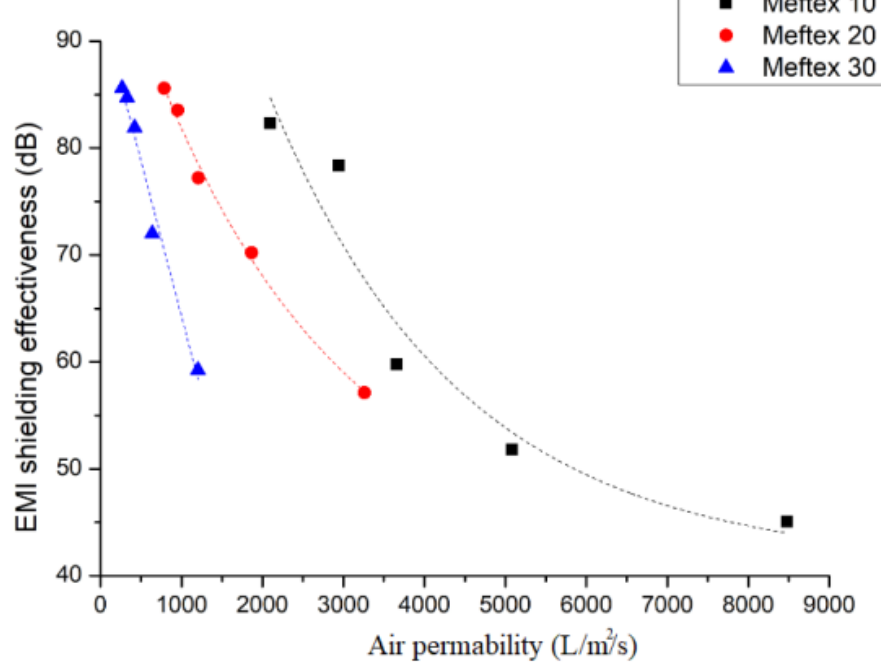
Figure 10. The relationship between air permeability and EMSE of MEFTEX.